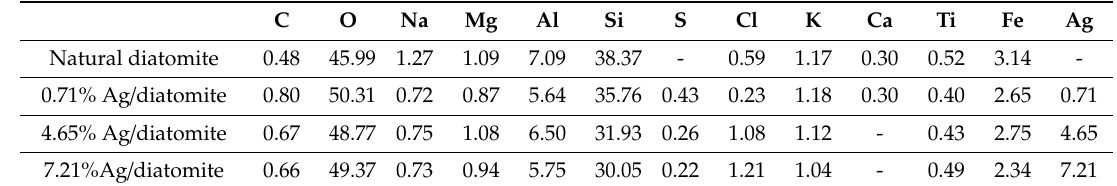
Table 1. Elemental composition of natural diatomite and (AgCl, Ag)NPs/diatomite composite.